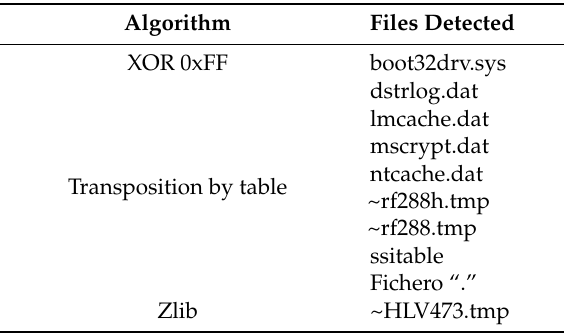
Table 11. Packaging and encryption